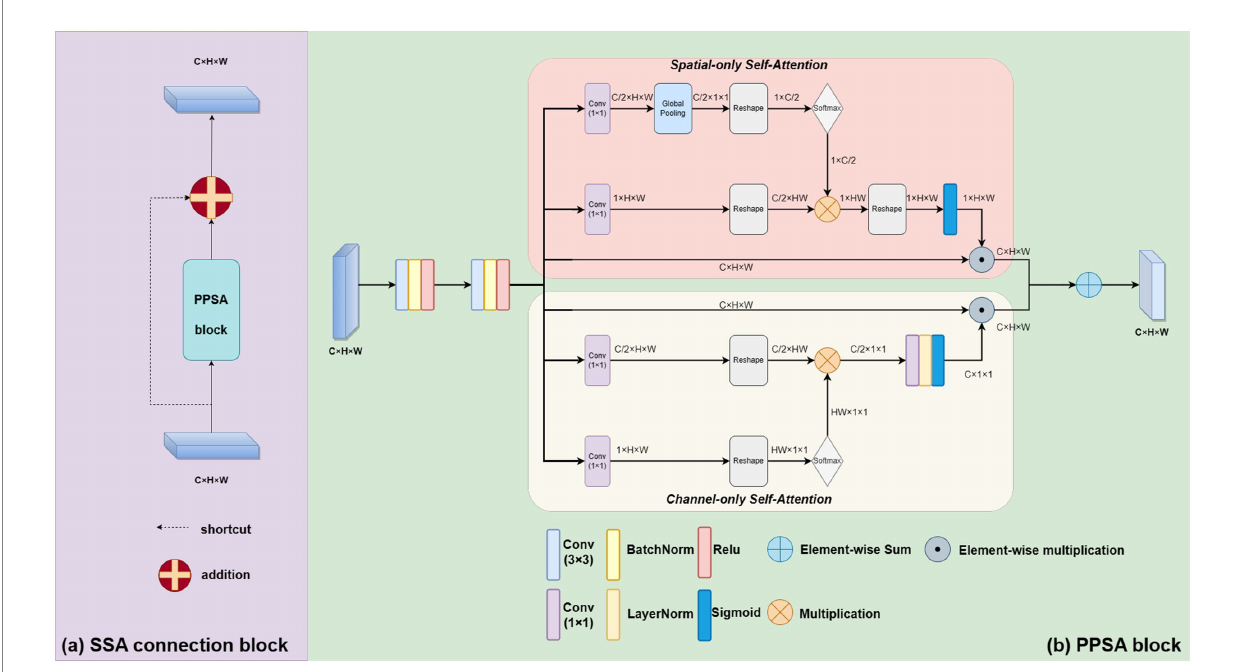
FIGURE 3 The proposed novel SSA connection block. As shown in subfigure (A) , it contains a shortcut path and PPSA block paths. The PPSA block is shown in subfigure (B)